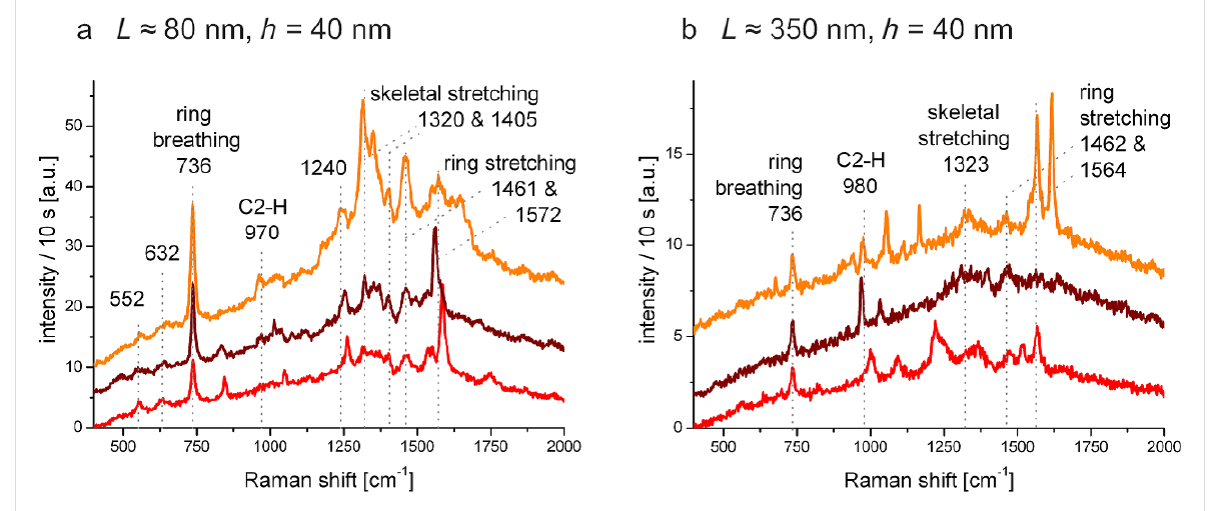
Figure 8: Surface-enhanced Raman spectra of an adenine (sub-)monolayer on gold Fisher patterns on glass. The nano-triangles which were used had an edge length of (a) L ≈ 80 nm and (b) L ≈ 350 nm. In both cases, their height was h ≈ 40 nm. Three spectra, offset for clarity, are shown in both cases to demonstrate the reproducibility of the measurements at different spots. All spectra were recorded in radial donut mode ( λ = 632.8 nm, focal power 250 µW) and with an acquisition time of 10